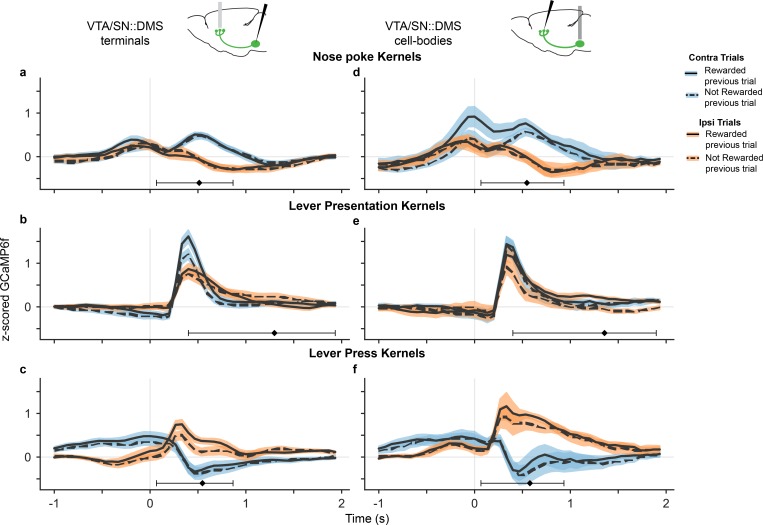
Kernels for each significant behavioral event from the multiple event kernel analysis.(a) Nose poke kernel output from linear regression model using GCaMP6f from VTA/SN::DMS terminals. Each line is the kernel for a combination of contralateral (blue) and ipsilateral (orange) trials, as well as rewarded (solid) and non-rewarded (dotted) trials. Colored fringes represent ±1 standard error from activity averaged across recording sites (n = 12). Black diamond represents the average latency for lever presentation from nose poke with the error bars showing the spread of 80% of the latency values. (b) Lever presentation kernels, with the black diamond representing the average latency from lever press to lever presentation. (c) Lever press kernels, with the black diamond representing the average latency from CS +or CS- to lever press. (d-f) Same as (a-e), except with signals from VTA/SN::DMS cell bodies averaged across recording sites (n = 7) instead of terminals.